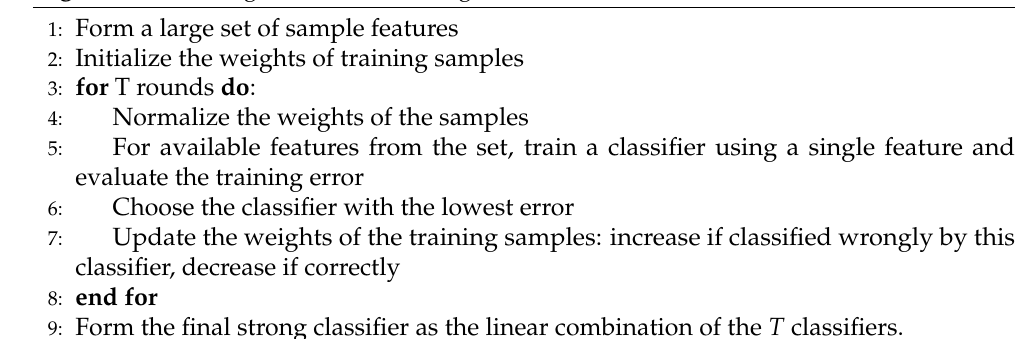
Algorithm 2 The algorithm for boosting classifier